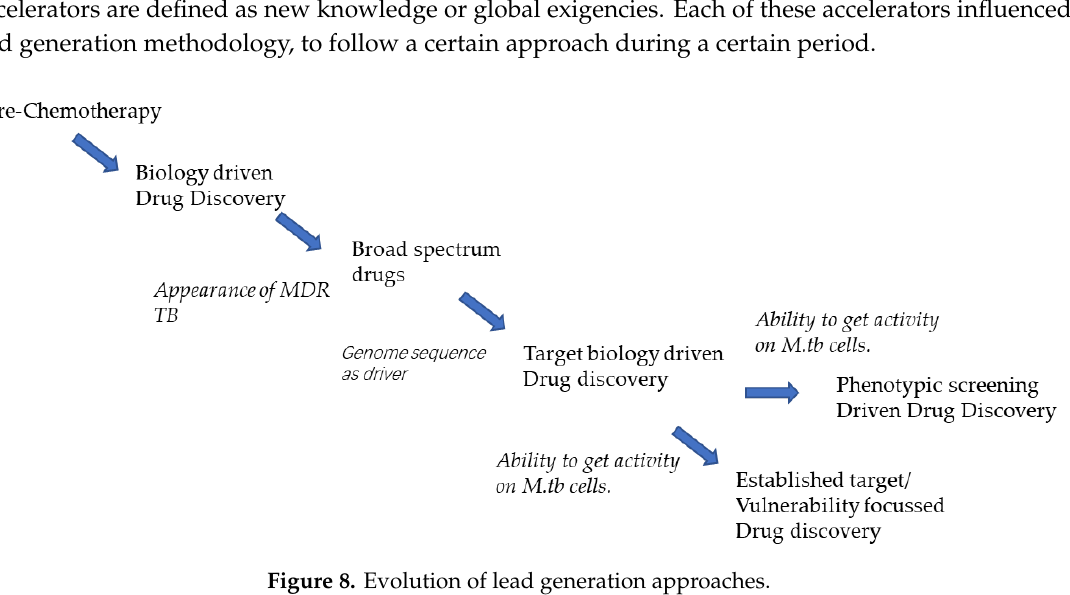
Figure 8. Evolution of lead generation approaches.